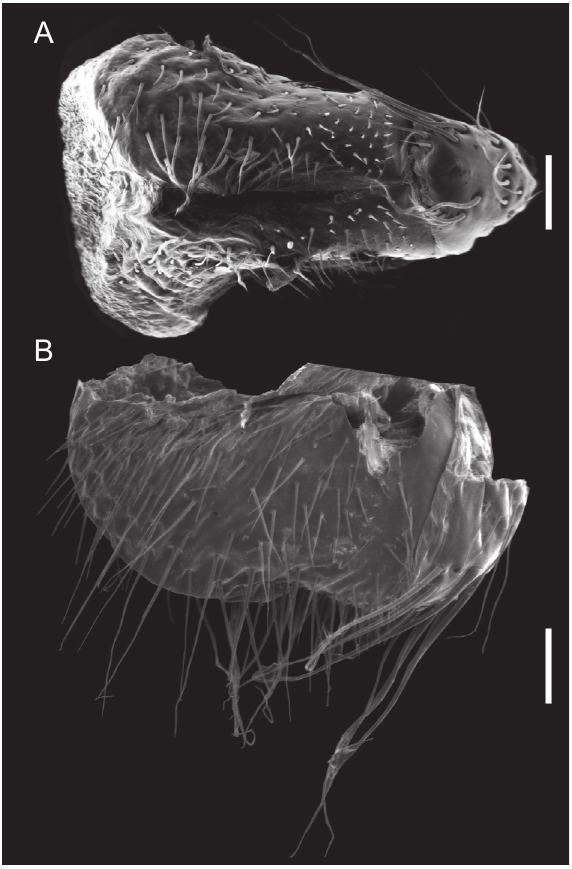
Fig. 6. A . Pogonosternum laetificum Jeekel, 1982 (NMV K-12203), right vulva, ventral view. B . P. nigrovirgatum (Carl, 1902) (NMV K-13356), right vulva, lateral view. Scale bars: 0.1